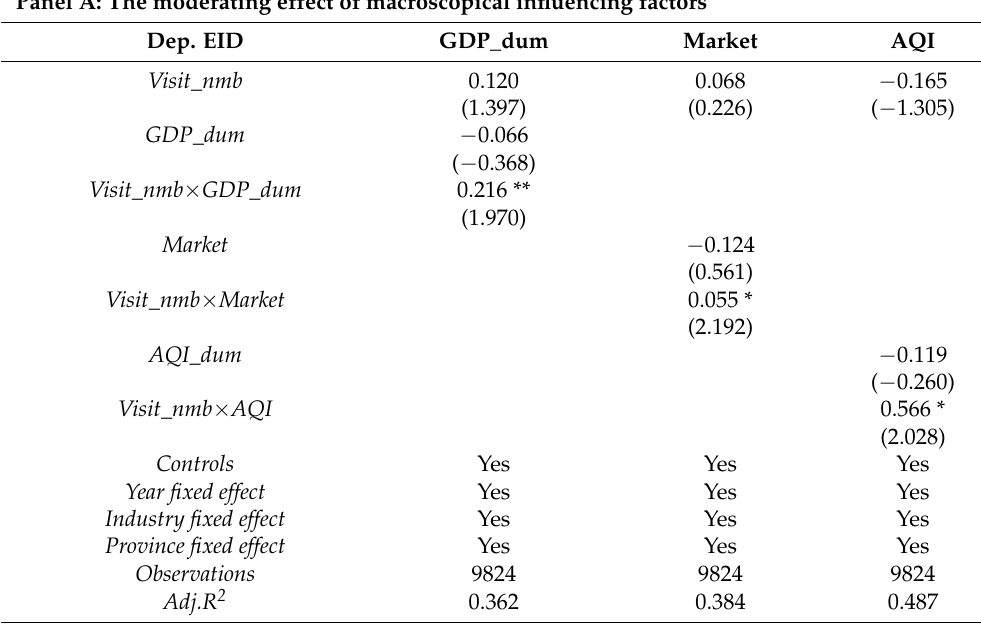
Table 4. Regression results of macroscopic and microscopic influencing factors. Panel A: The moderating effect of macroscopical influencing factors